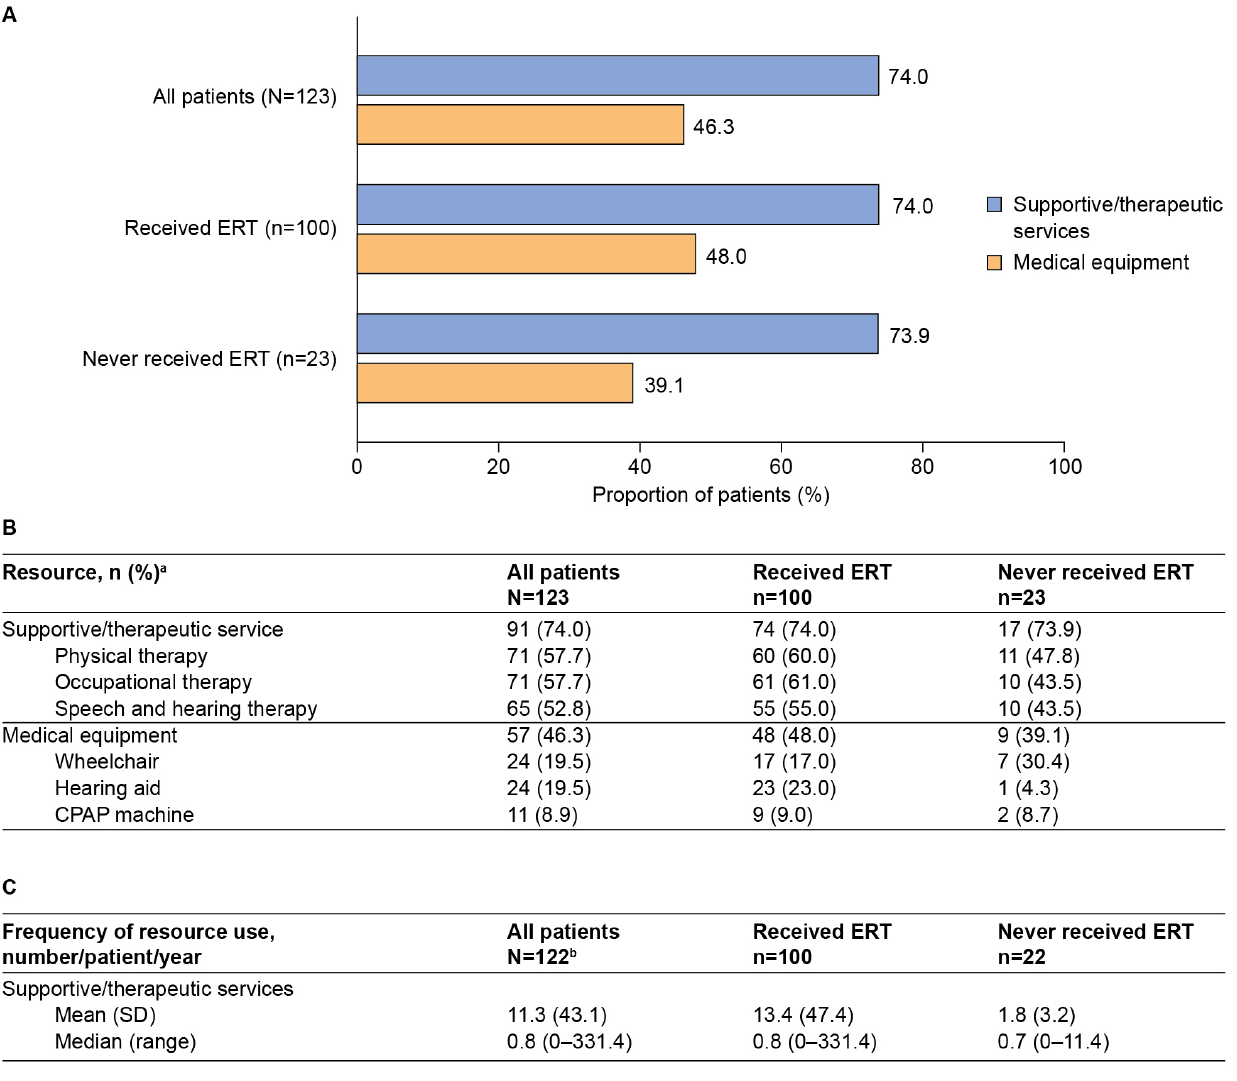
Figure 5. Summary of Supportive and Therapeutic Service Utilization (Resources Used at Least